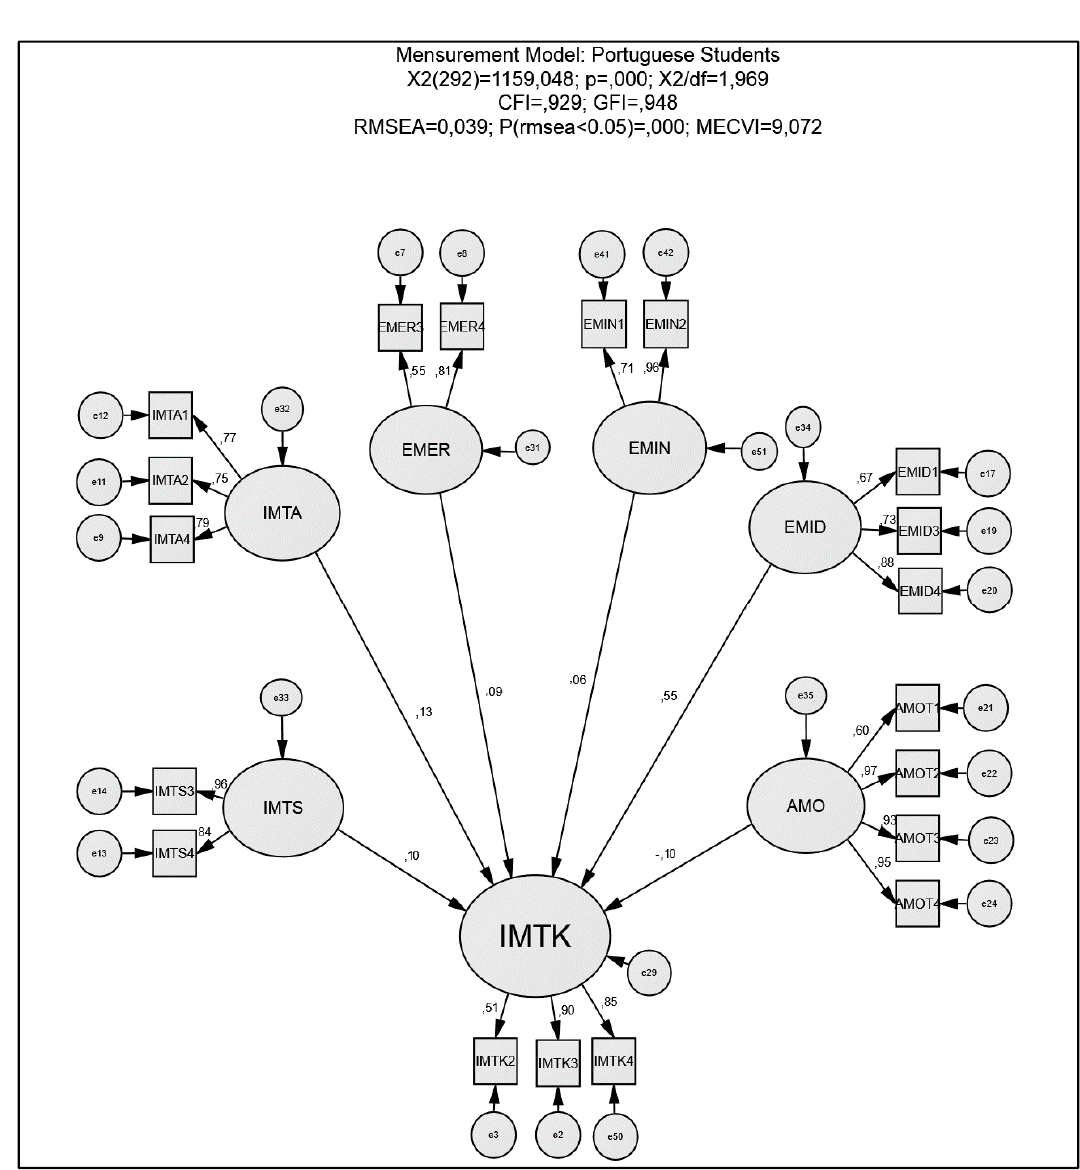
Figure 2. Structural Model-Portugal.